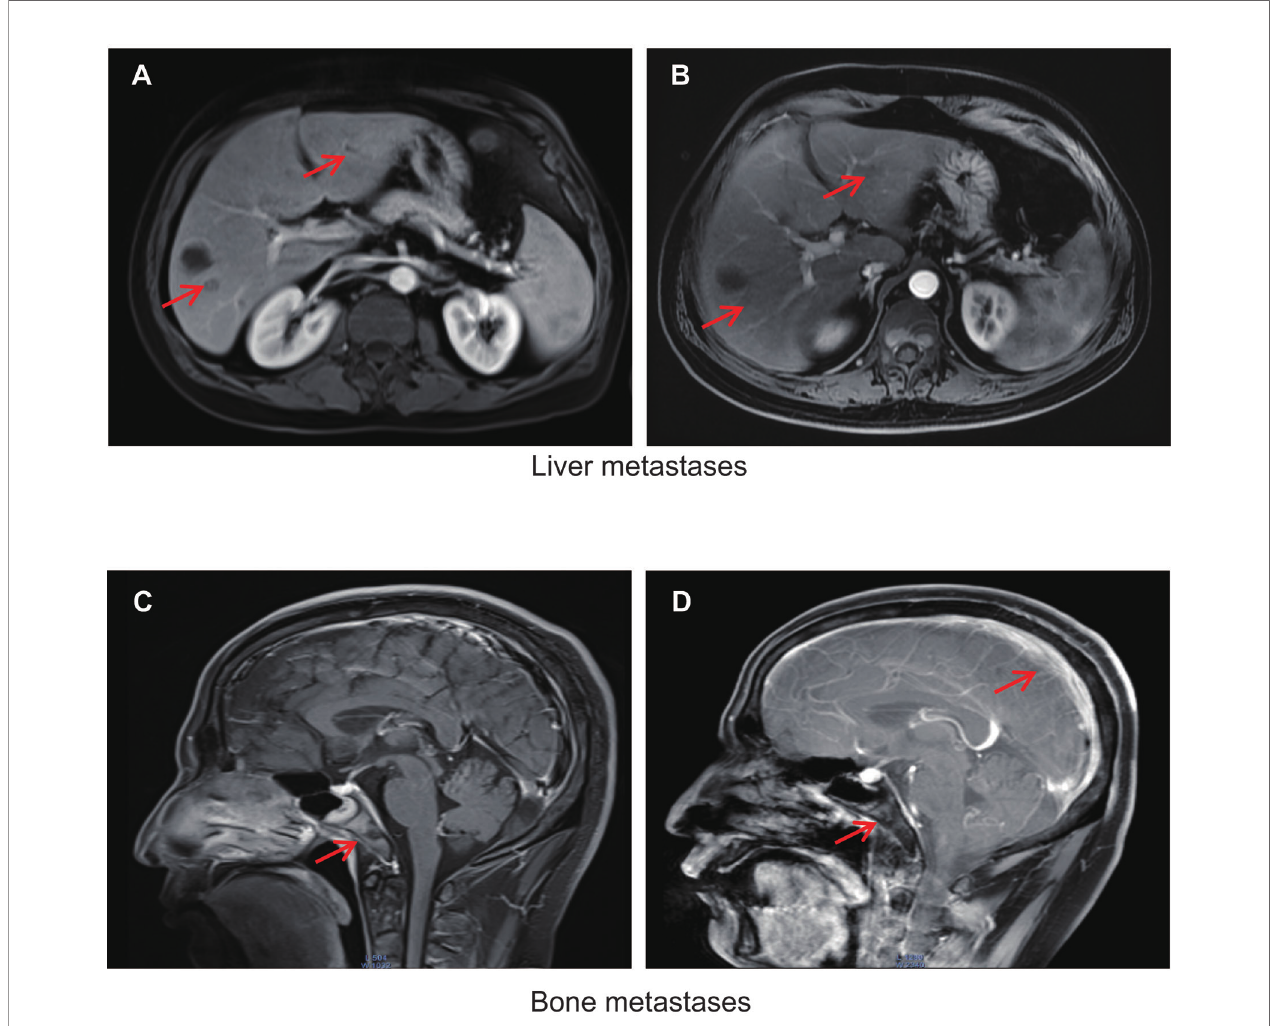
FIGURE 2 | (A) Liver metastases detected using magnetic resonance imaging (MRI) in November 2019. (B) Response of liver metastases detected using MRI in January 2020 after treatment with etoposide combined with cisplatin and continued ADT plus pembrolizumab. Metastases are indicated by red arrows. (C) Clivus and adjacent right sphenoid bone metastases detected by MRI in April 2020. (D) Meningeal clivus and adjacent right sphenoid metastases in November 2020. Metastases are indicated by red